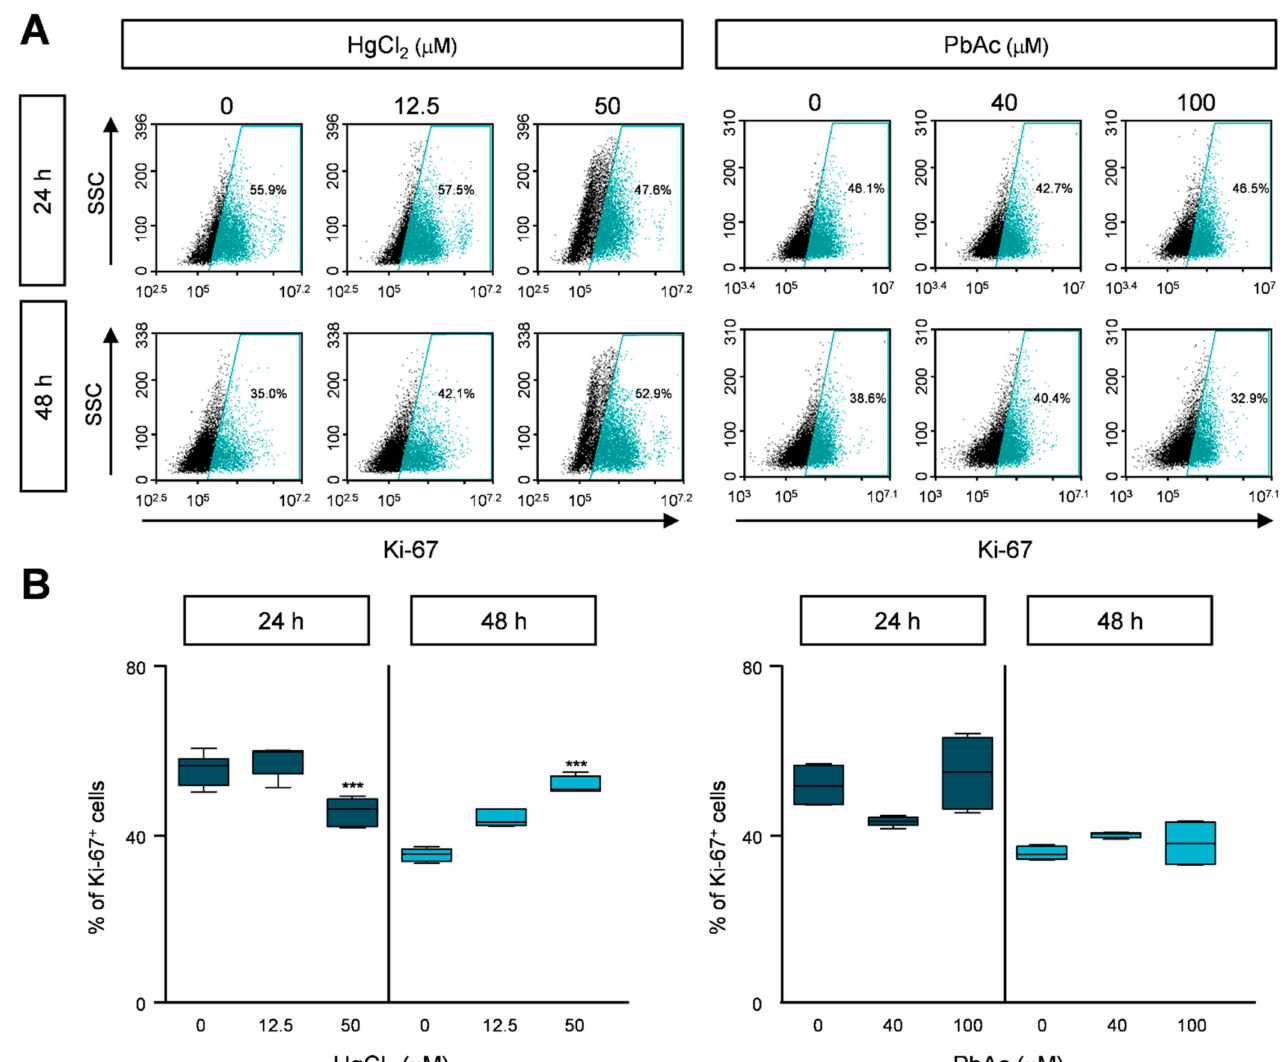
Figure 2. Heavy metals treatment reduced the proliferation of MRC5 cells. ( A ) The heavy metals-treated MRC5 cells were immunostained with anti-Ki-67 antibodies. The cells were counted by FACS analysis. ( B ) The percentages of Ki-67-positive population are represented as the mean ± S.E.M. of three independent experiments (n = 6), each performed in triplicate. Error bars show mean ± S.E.M. p values obtained by Student’s t -test. *** p value <